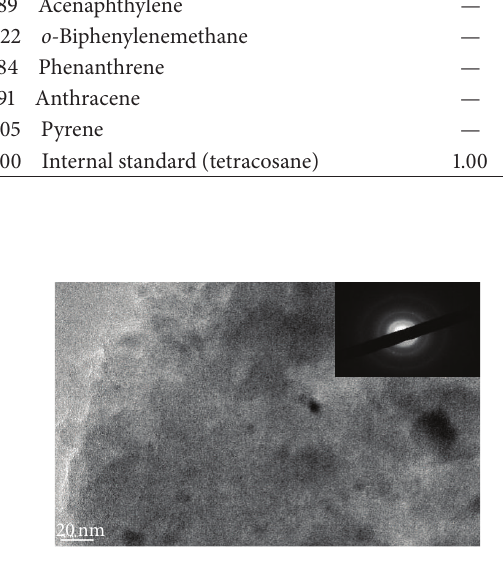
Figure 7: TEM image and SAED of char obtained from mixture of Japanese cedar wood meal/zeolite (ZSM-5) (1: 1 w/w) pyrolyzed at 800 ∘ C.